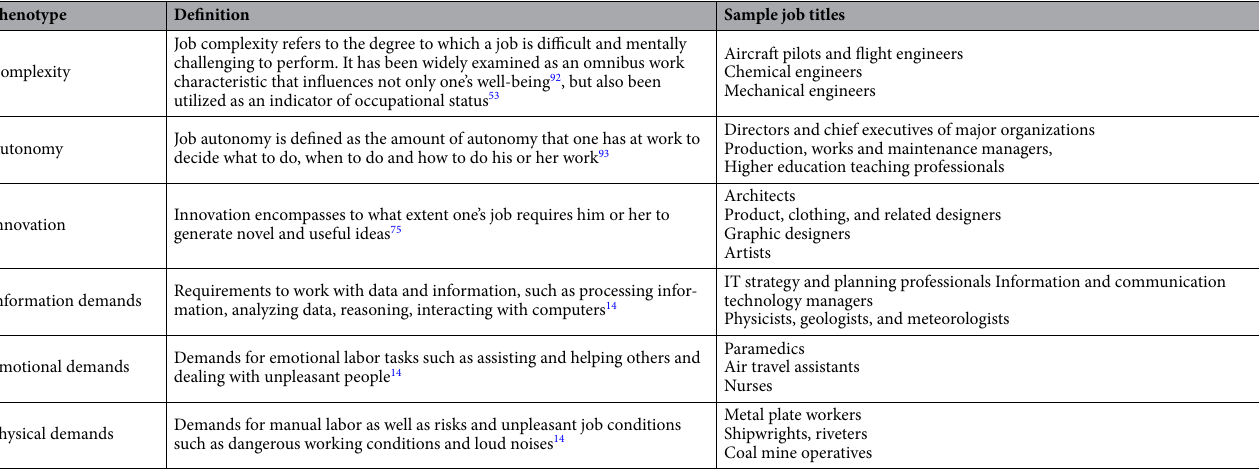
Box 1. Definitions of six job attainment characteristics and sample job titles.